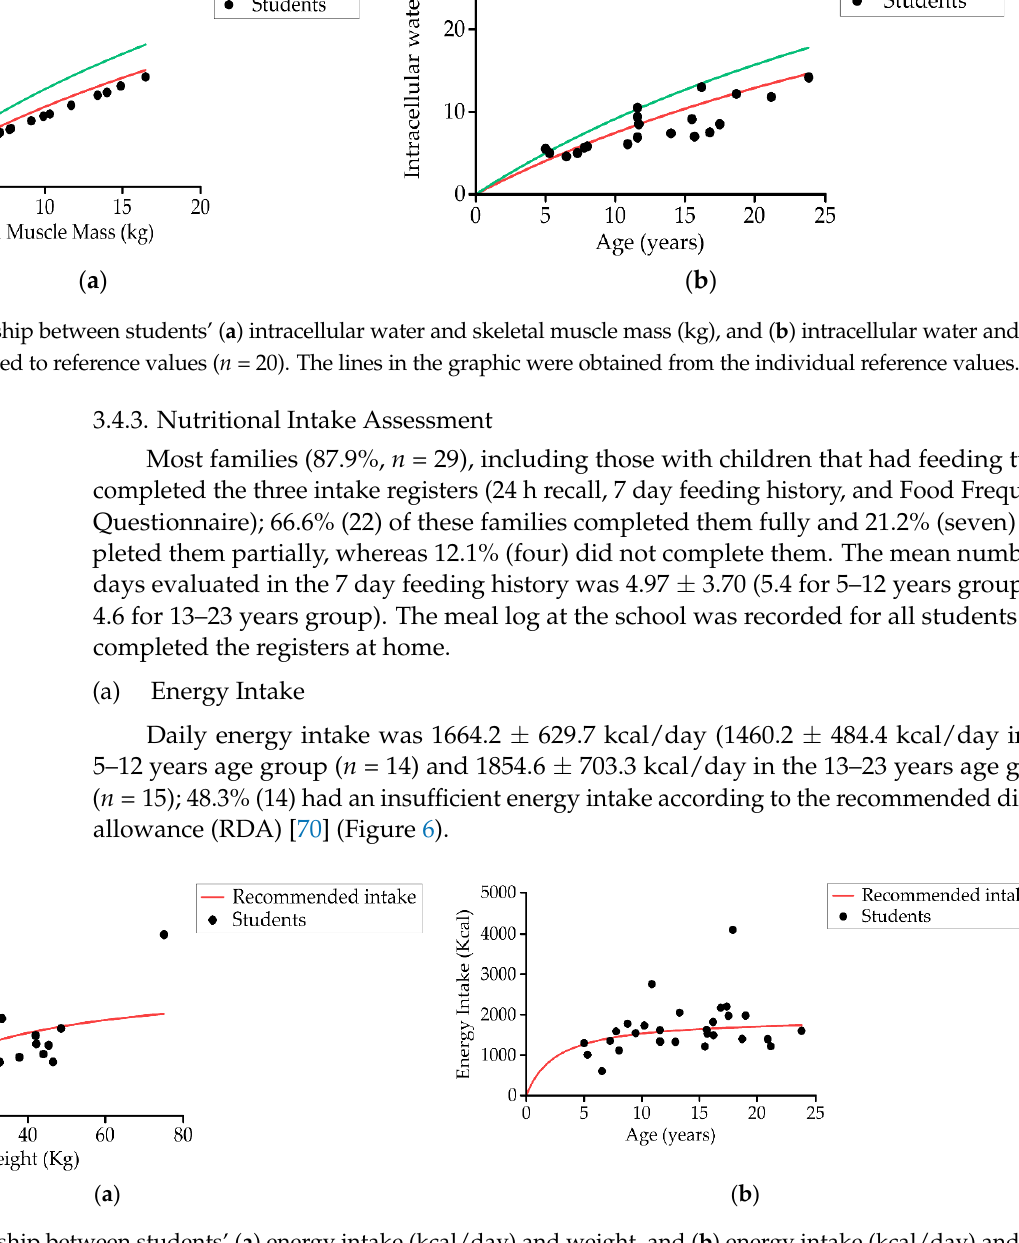
age compared to recommendations of energy intake ( n = 29).